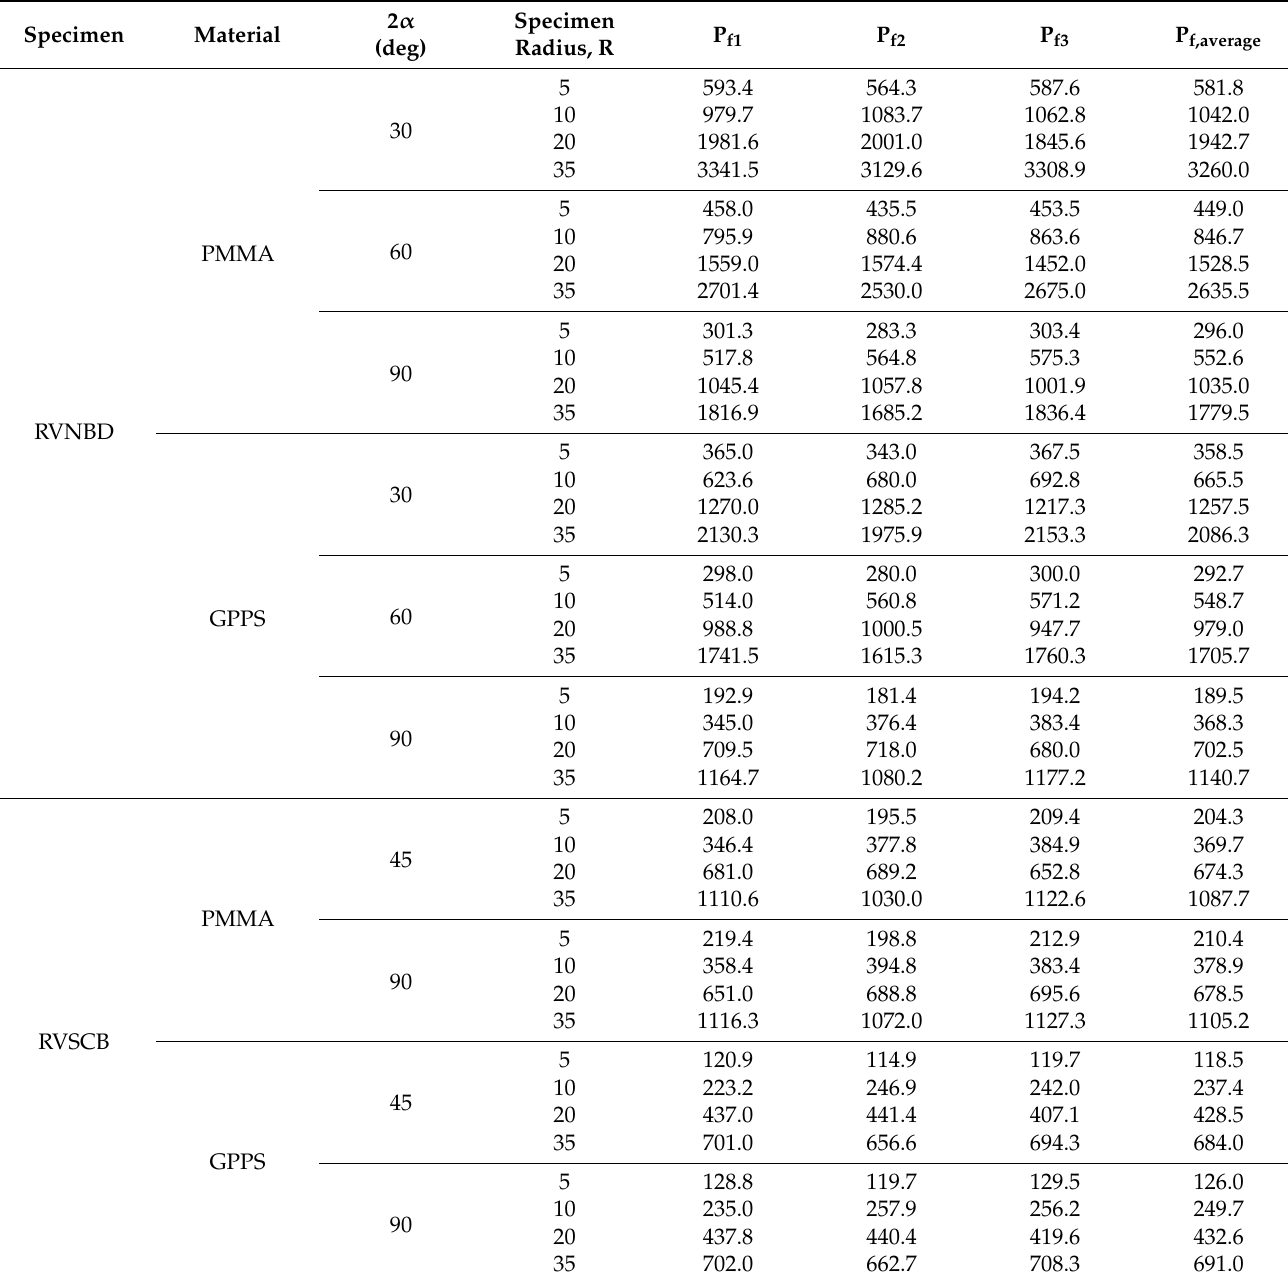
Table 3. The fracture loads of polymeric (PMMA and GPPS) RVNBD and RVSCB samples (dimensions in mm, load values in